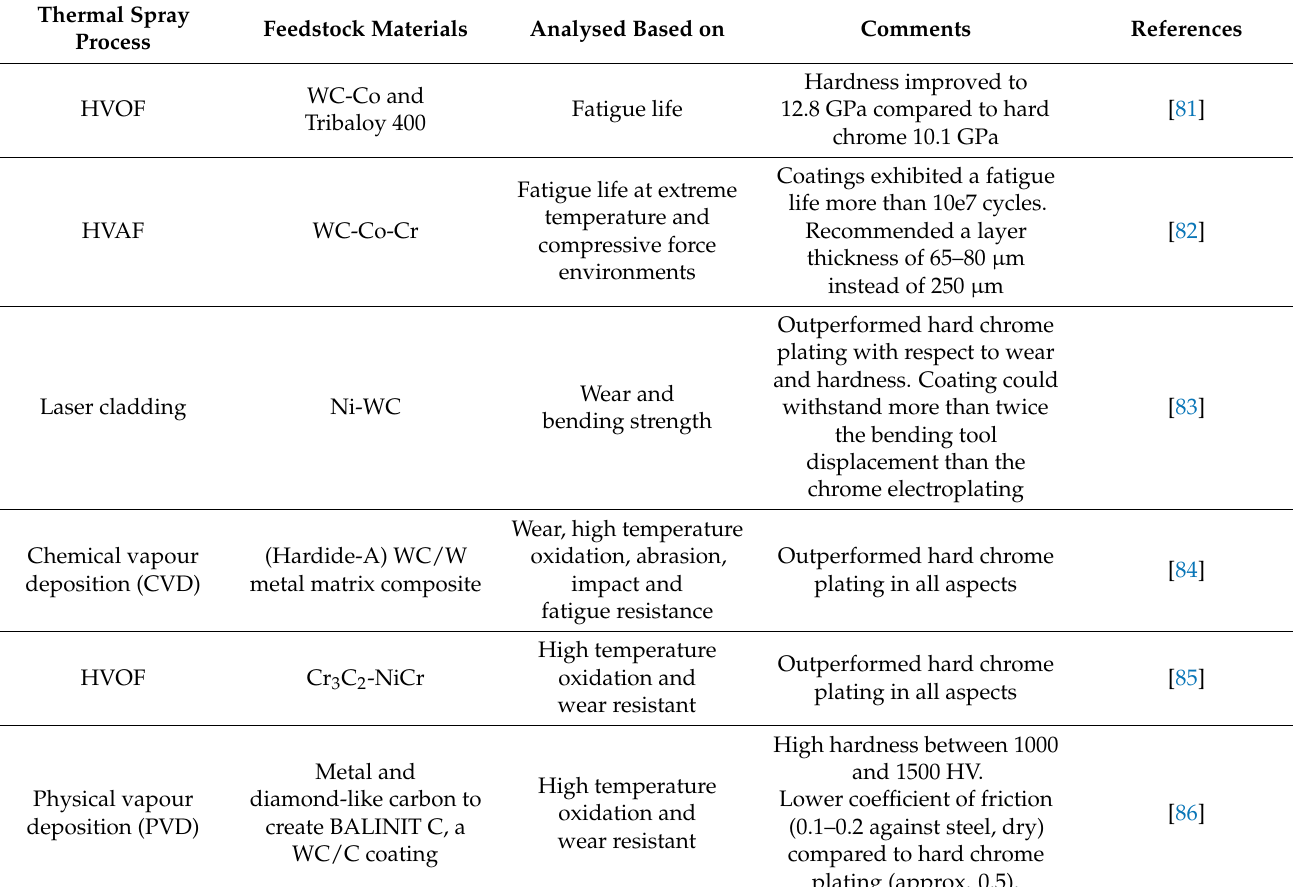
Table 2. Thermal spray processes and feedstock materials that have replaced hard chrome